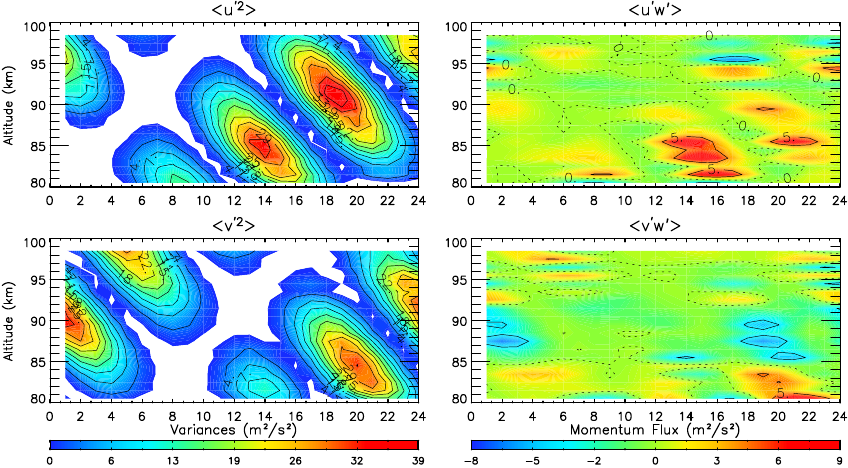
Fig. 10. As Fig. 9, but using intervals of 1h in time and 1km in height. The values for the momentum fluxes have been multiplied by